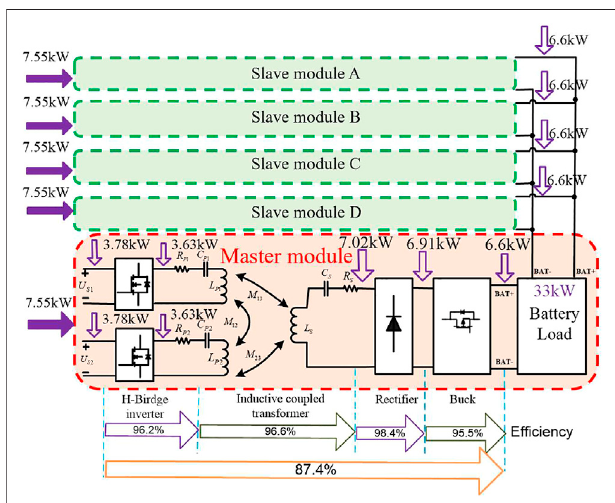
FIGURE 19 | System ef fi ciency in the aligned position.